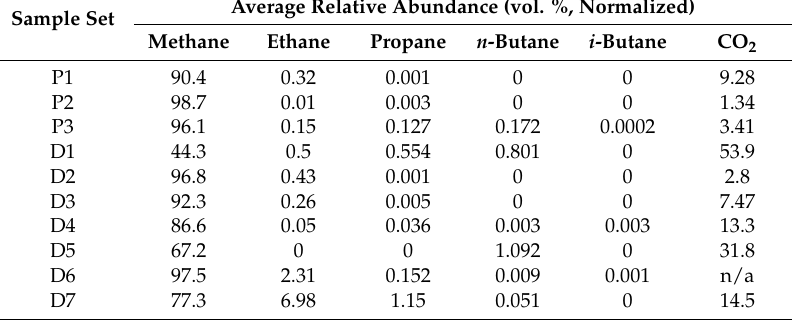
Table 2. Gas composition of samples collected from all 10 sample sets. Samples from different wells and canisters per sample set are averaged and presented per sample set. Volume percentages are normalized on the basis of methane, ethane, propane, n –butane, i –butane and carbon dioxide. Average Relative Abundance (vol. %, Normalized) Sample Set Methane Ethane Propane n -Butane i -Butane CO 2 P1 90.4 0.32